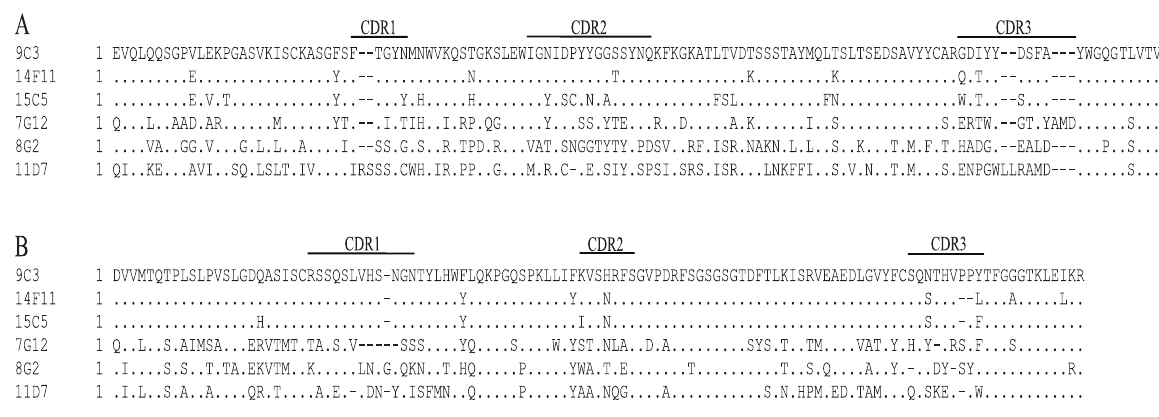
Figure 3. Sequence alignment of the mAb heavy and light chains. Alignment of heavy ( A ) and light ( B ) chain amino acid sequences using the Global-Reference alignment tool in Clone Manager 9. Like amino acids are represented by (.), gaps introduced into sequences to optimize alignment are represented by (-). CDR regions are labeled according to Kabat’s